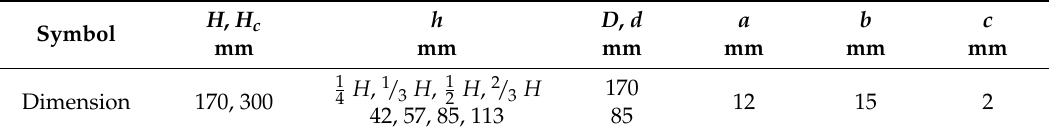
Figure 1. Schematic diagram of the experimental setup with a Rushton turbine and an agitated vessel ( a ) and a photo of the experimental setup ( b ). Table 1. Dimensions of the stirred tank and the Rushton turbine.